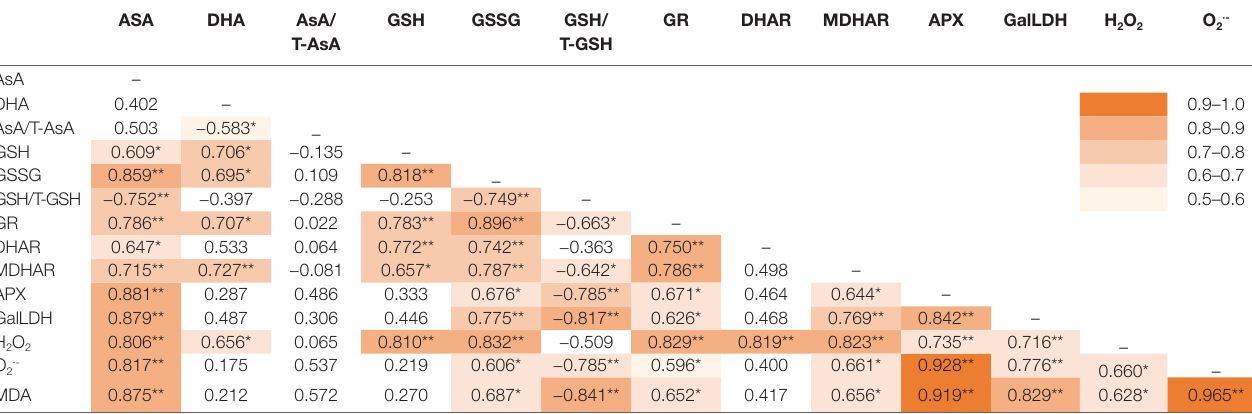
Each square indicates the Pearson’s correlation coefficient of a pair of parameters. Correlation was significant at *p < 0.05; **p < 0.01. The deeper the color is, the greater the correlation coefficient.